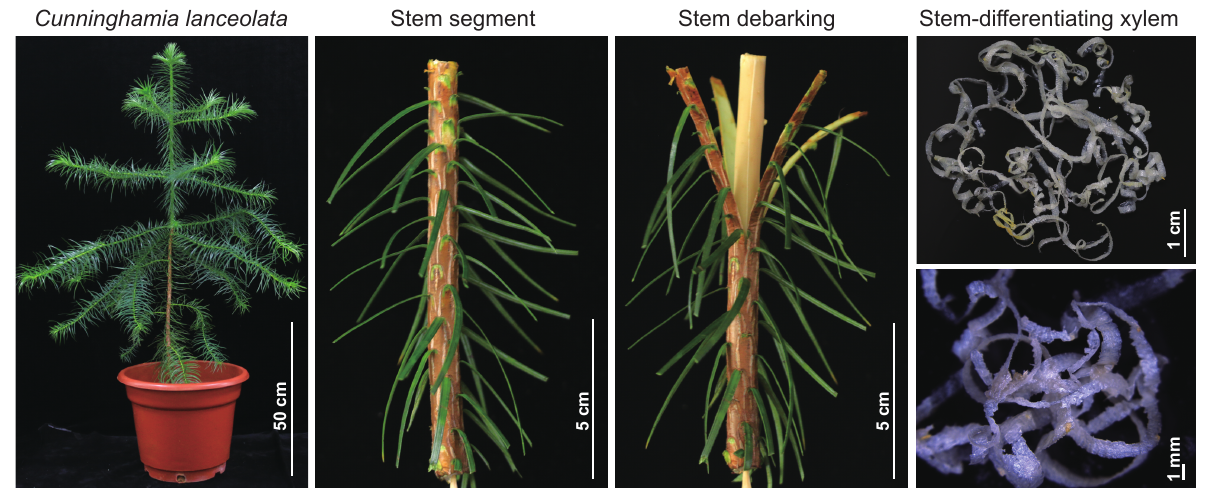
Figure 2. Schematic drawing of secondary xylem of C. lanceolata . After PEG, SA, and